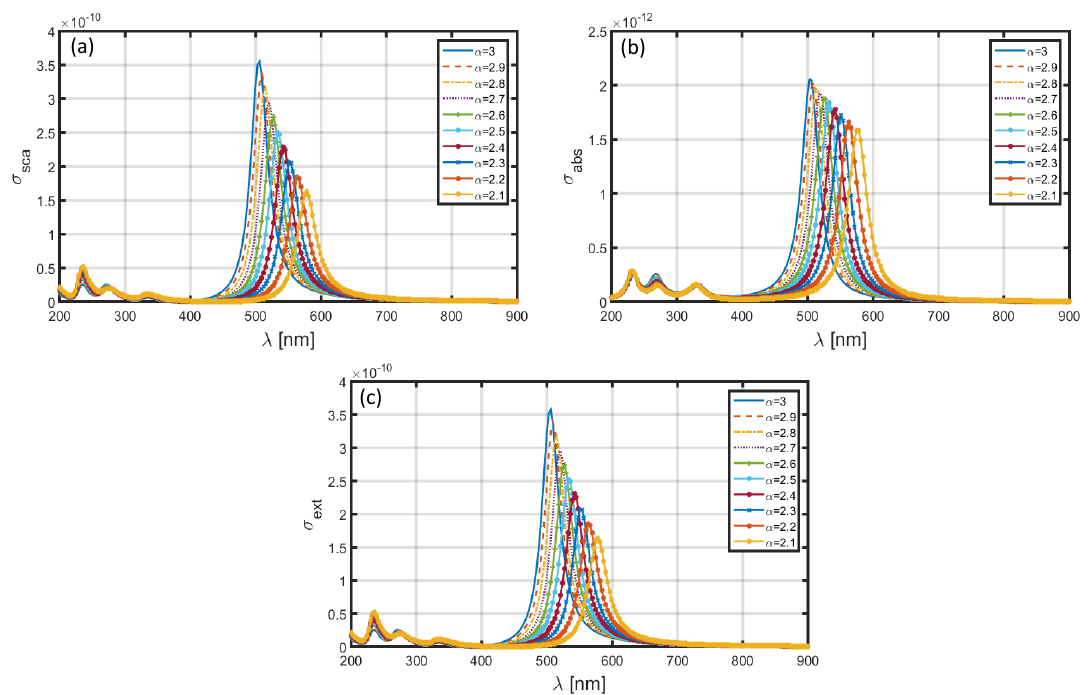
Figure 11. Plots of ( a ) scattering cross-section, ( b ) absorption cross-section, and ( c ) extinction coe ffi cient against λ for SiO 2 -Ag nanoparticle in the FD space corresponding to the dimensions a = 60 nm, b = 80 nm.